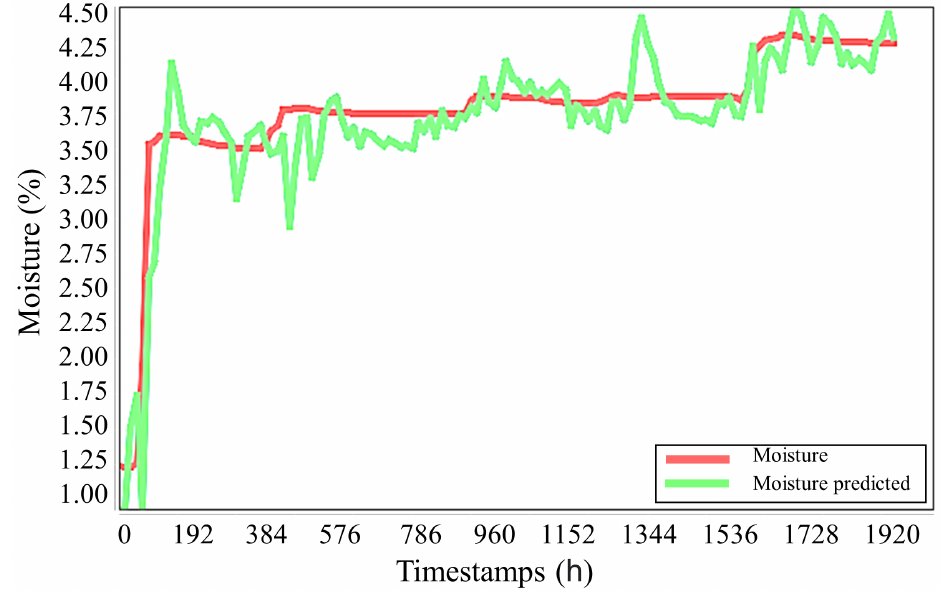
Figure 7. Results of the LSTM-based moisture forecasting model.